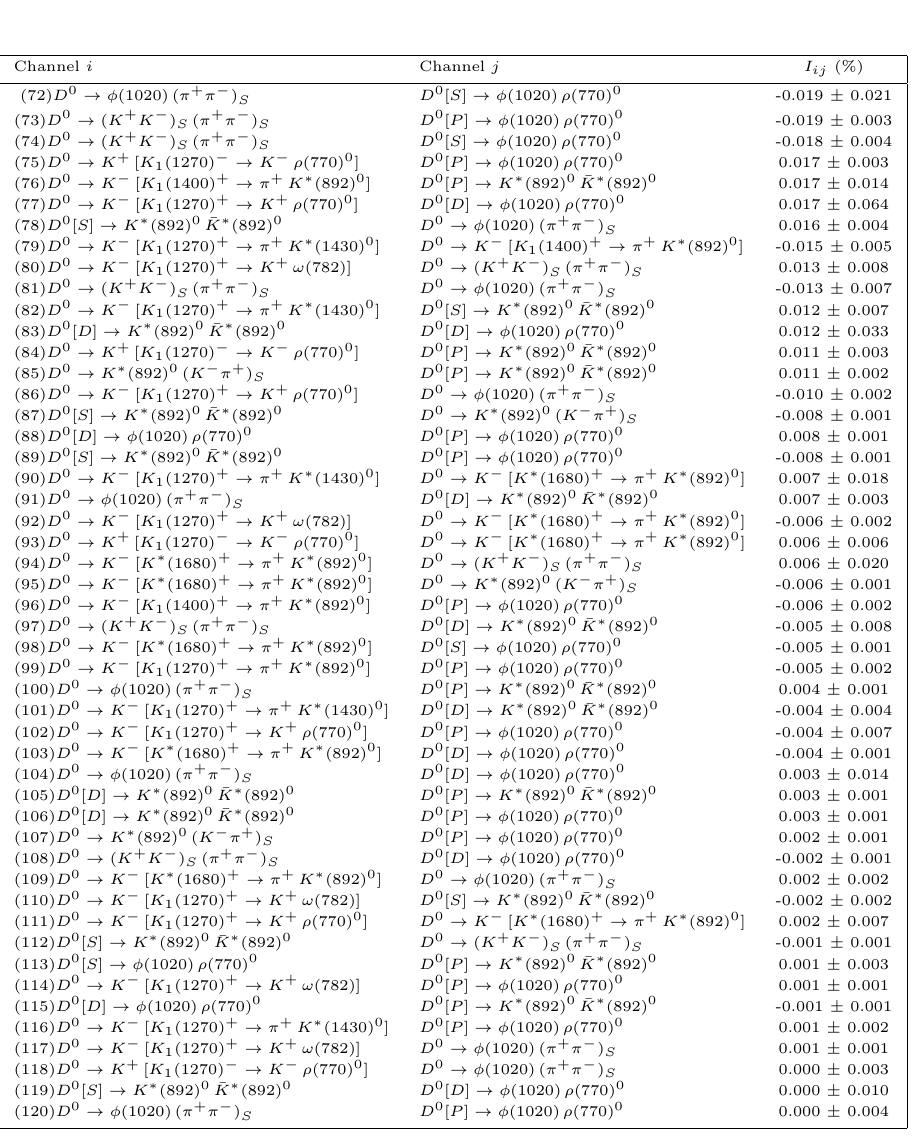
Table 24 . Interference fractions j I ij j < 0 : 02%, as de(cid:12)ned in eq. (4.27), ordered by magnitude, for the nominal D ! K + K (cid:0) (cid:25) + (cid:25) (cid:0) amplitude (cid:12)t. Only the statistical uncertainties are given.